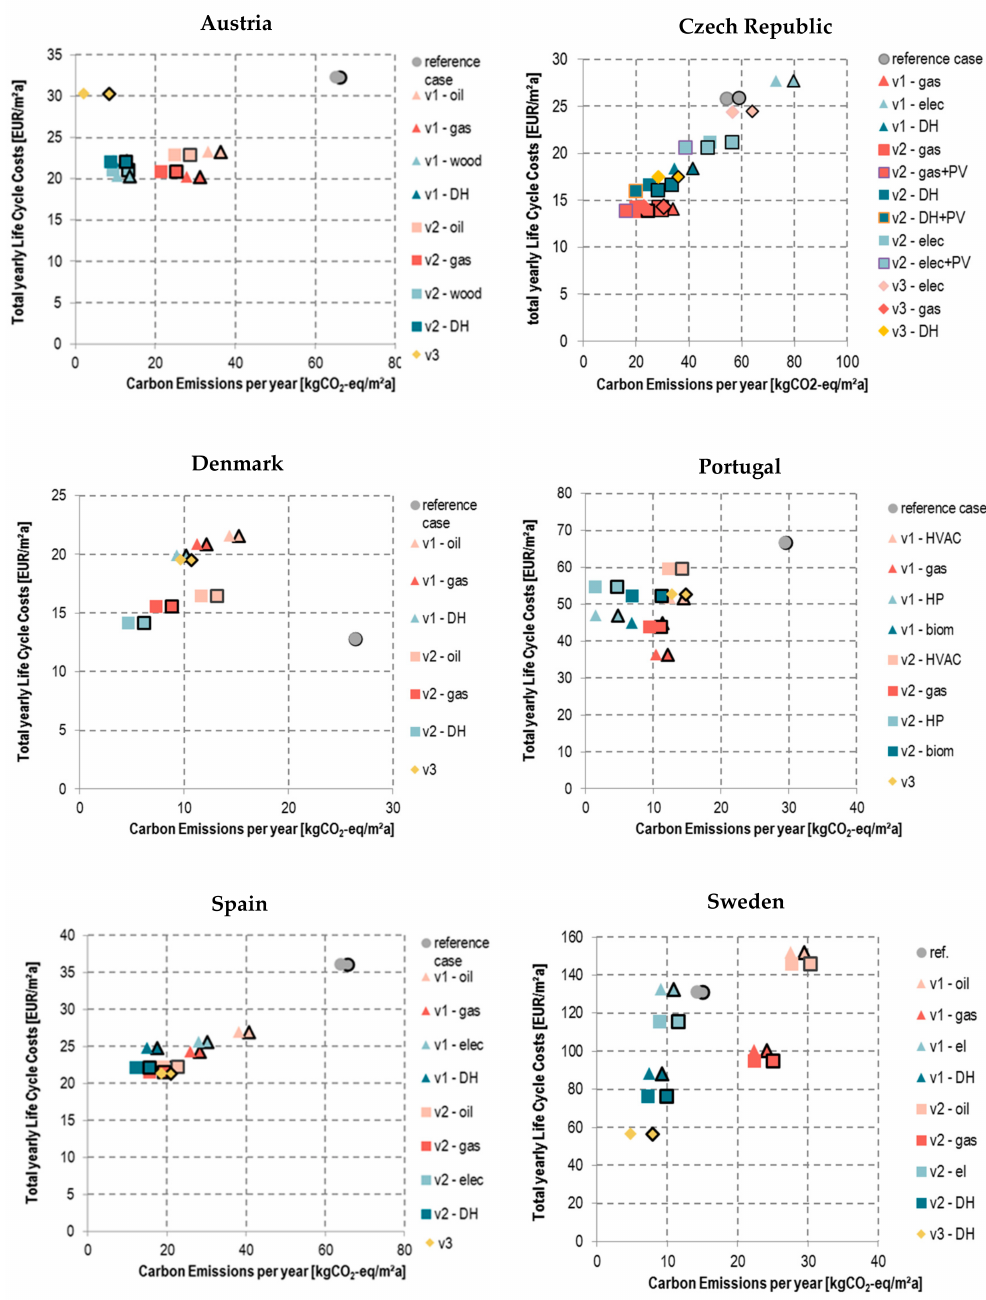
Figure 4. Comparison of calculations for carbon emissions for the six case studies, without including embodied carbon emissions and with embodied carbon emissions (marked with a black outline) for the different renovation